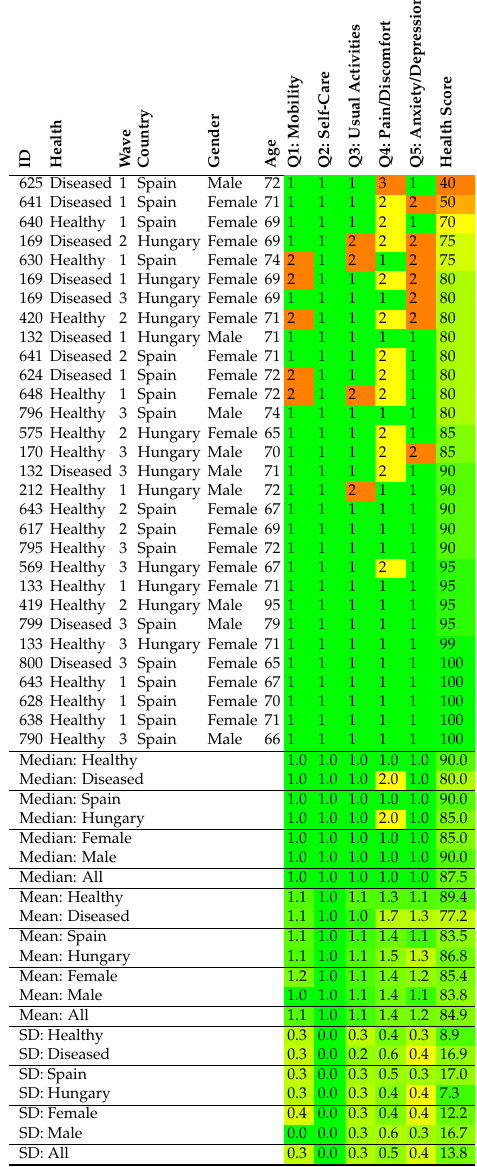
Color coding: from orange (worse outcome relative to others) to yellow to reen (better